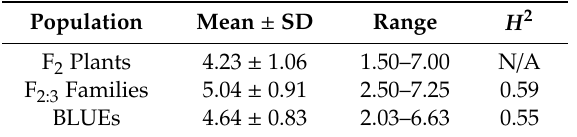
Table 1. Phenotypic performance of anther extrusion in F 2 plants, F 2:3 families, and their corresponding best linear unbiased estimations